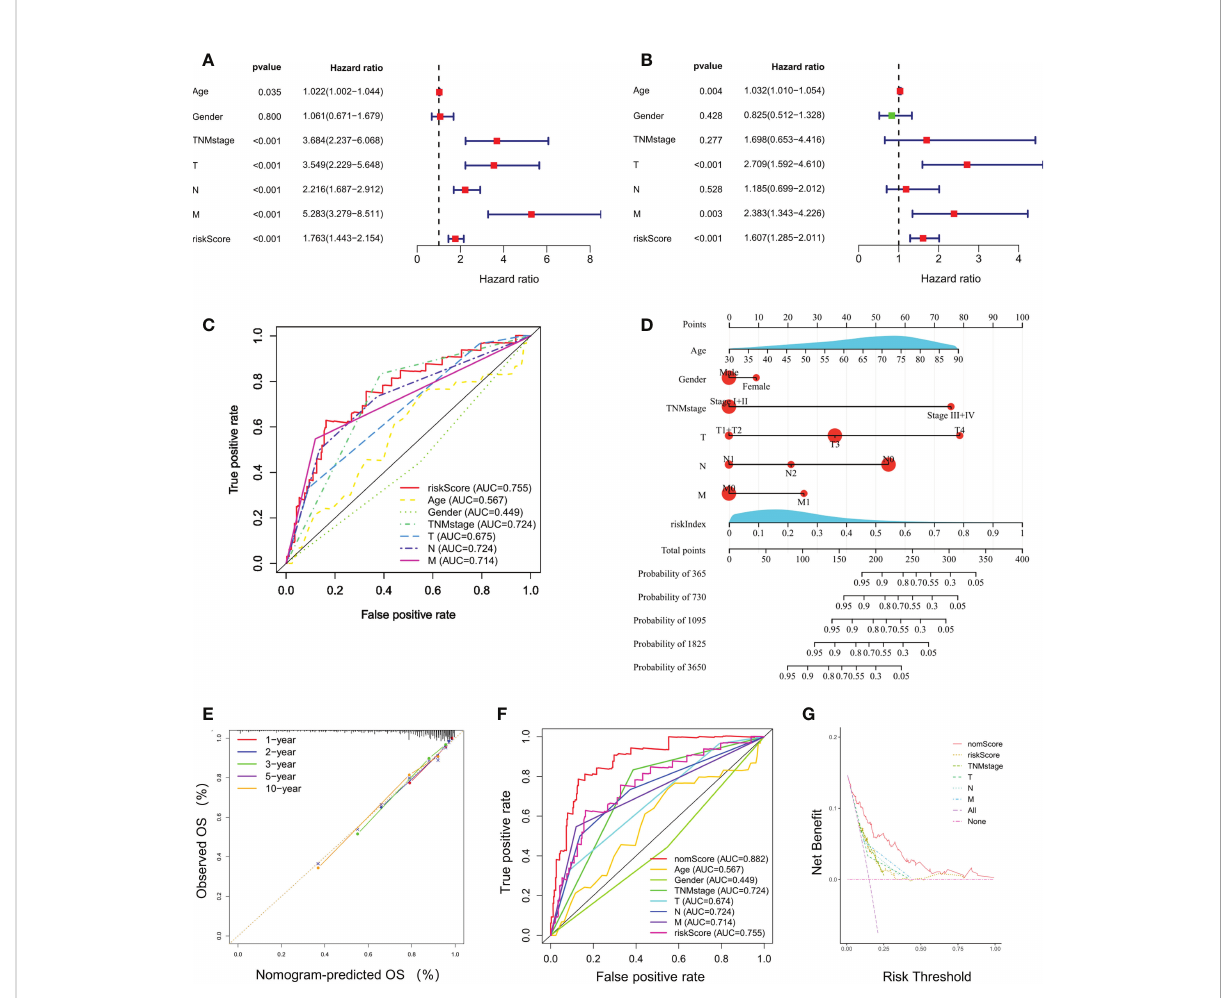
FIGURE 3 Independent prognostic power of the selected four-gene signature. (A, B) Univariate and multivariate Cox regression analyses of the relationship between different clinical parameters and riskScore with OS. (C) Evaluation of the prognostic utility of the riskScore and clinical parameters using ROC curves. (D) Nomogram comprised the riskIndex and clinical parameters for predicting the prognosis probability in CRC. (E) Calibration curves of the nomogram showed consistency in the predicted and observed 1-, 2-, 3-, 5 and 10-year survival rates. (F) ROC curve analysis of the nomogram for OS. (G) Decision curve analysis (DCA) of the nomogram compared with other